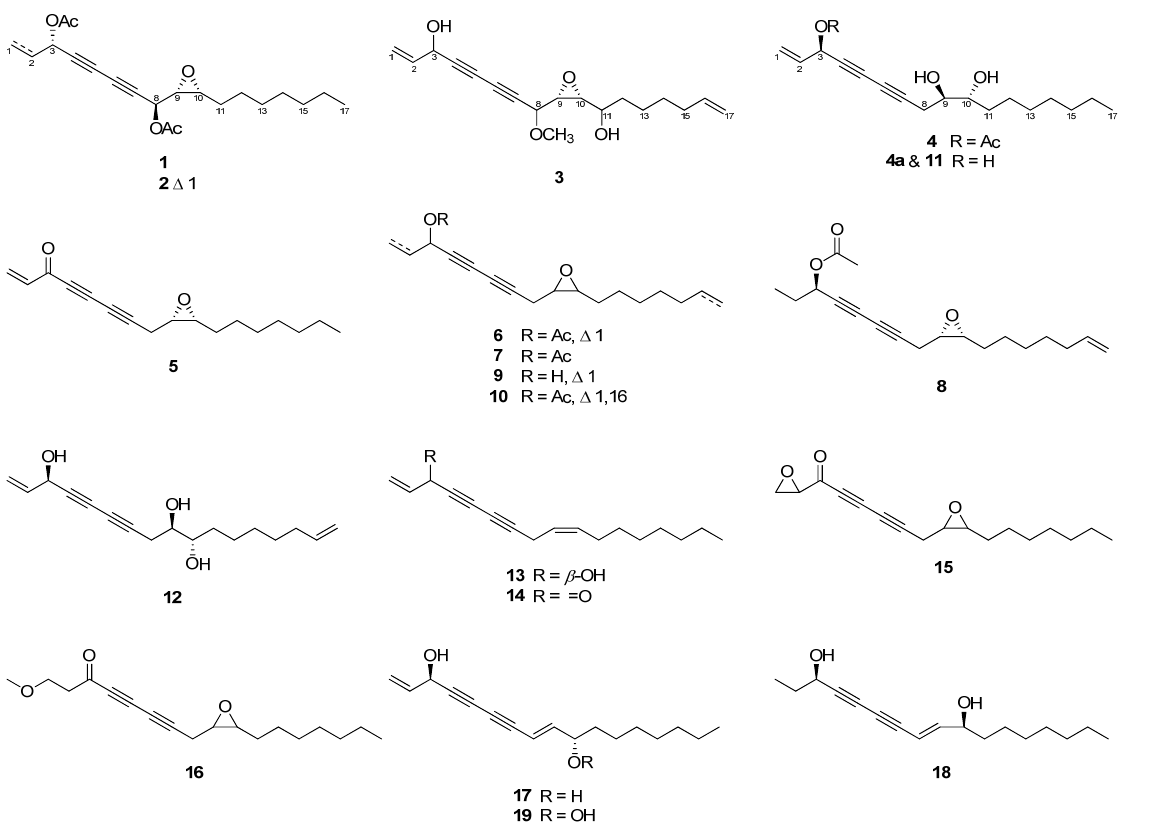
Figure 1. Chemical structures of compounds 1 – 19 isolated from the roots of P . ginseng